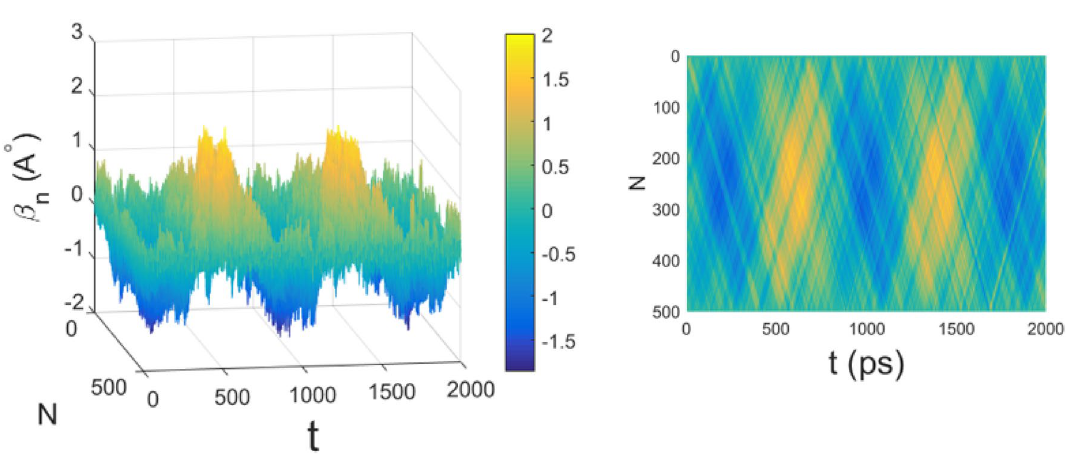
500 amino acids. The parameter = 13 s.